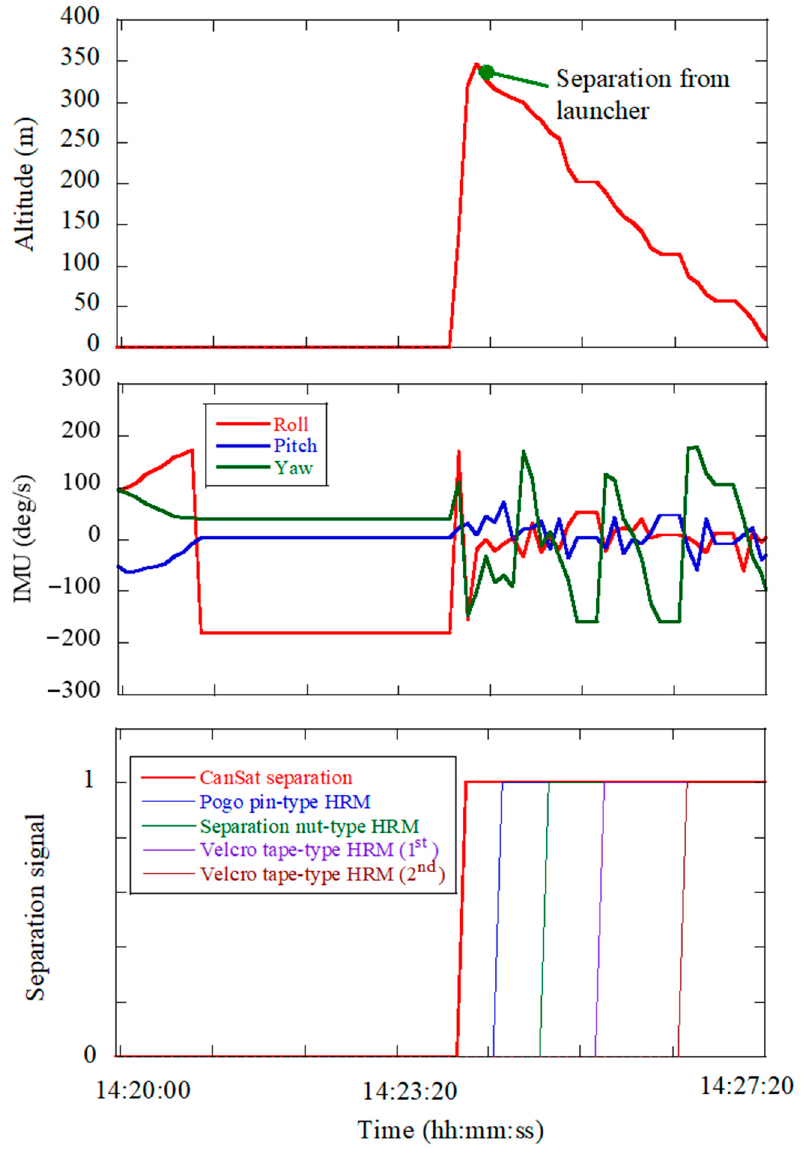
Figure 14. Launch status data obtained from the GPS, IMU, and OBC during the flight of the DHRM CanSat.